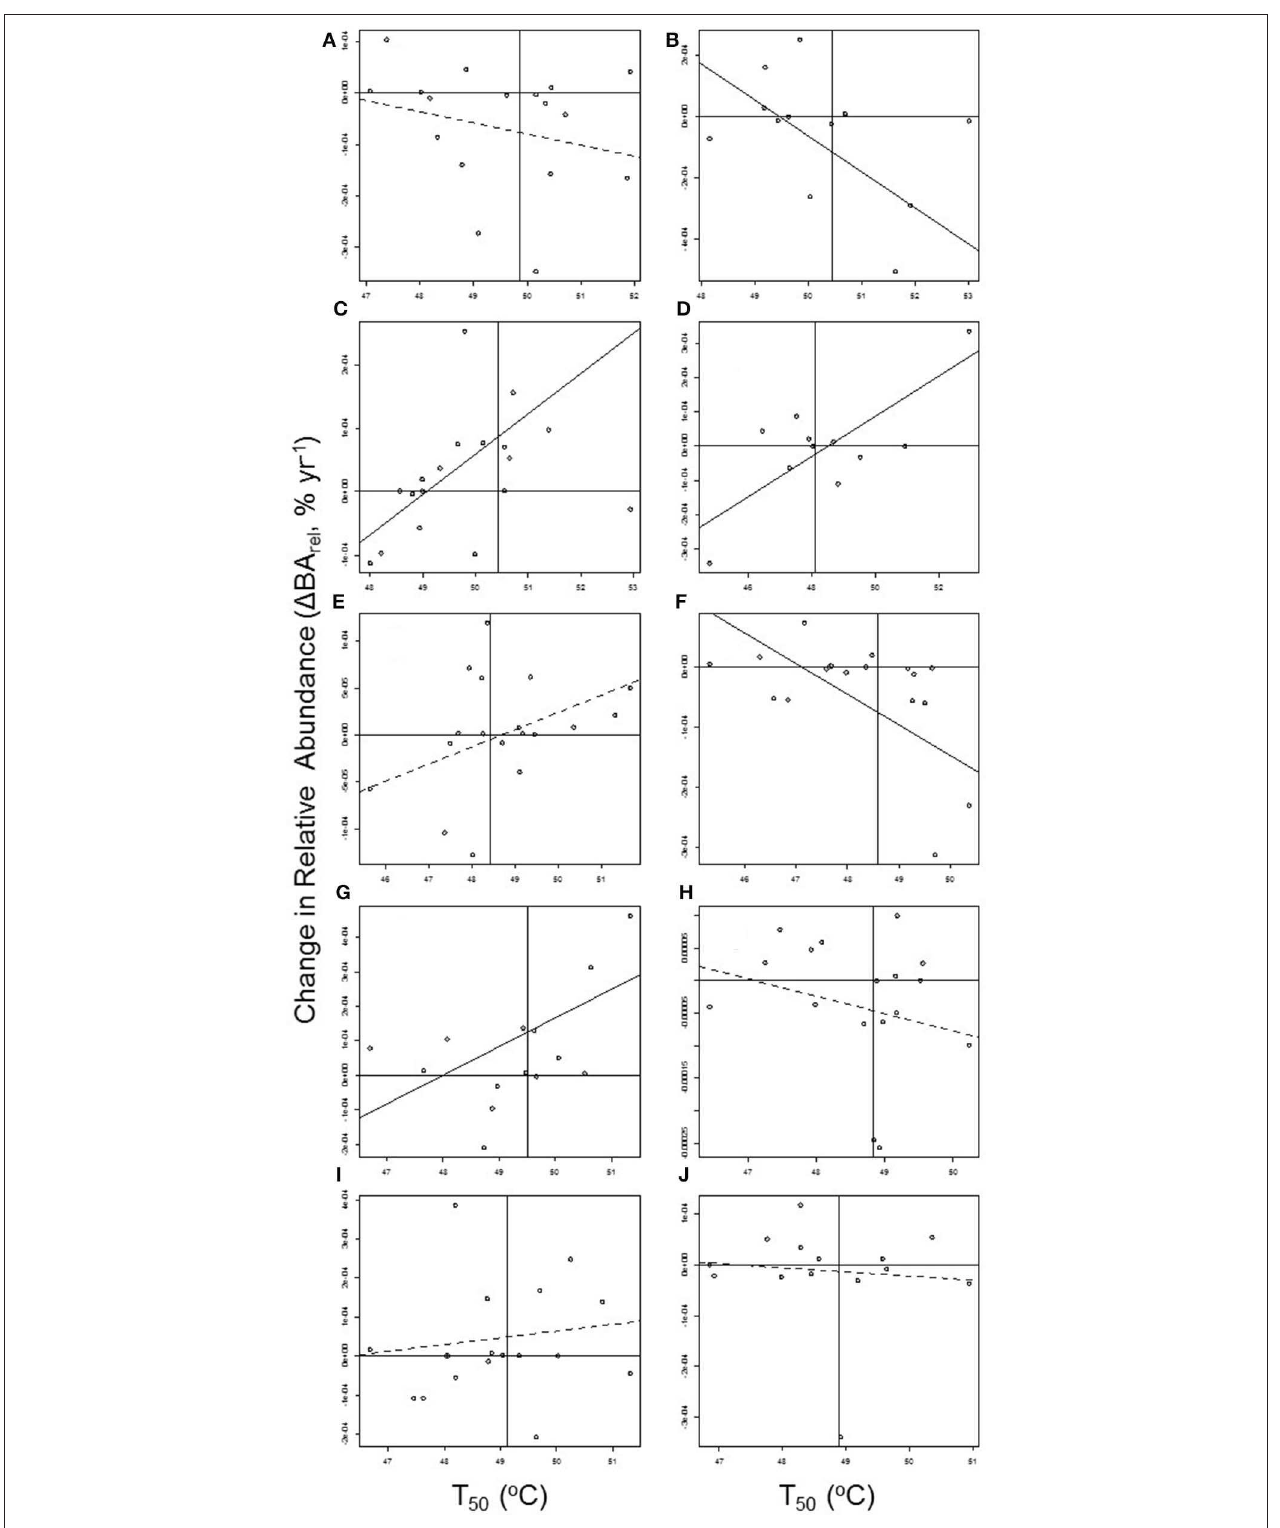
FIGURE 6 | The within-plot relationships between annual changes in species’ relative abundance ( 1 BA rel ) and species’ T 50 . Horizontal lines indicate no change in abundance through time and vertical lines indicate plot-average T 50 . Solid regression lines indicate significant ( p ≤ 0.05) relationships (weighted regressions with